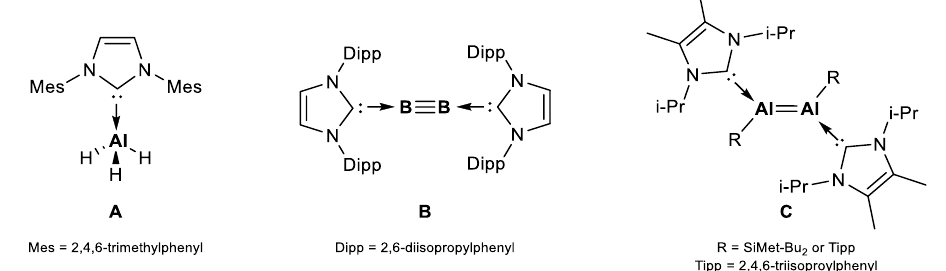
Figure 1. Examples of NHC-stabilised group 13 complexes.